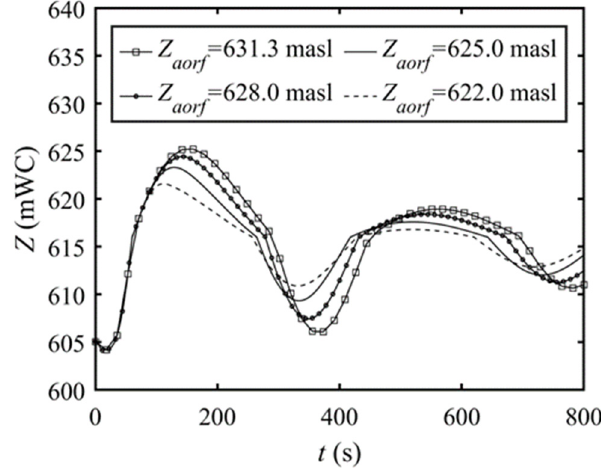
Figure 7. Load rejection—STWL of the semi-pneumatic throttled chamber surge tank for various vertical positions of the aeration orifice.